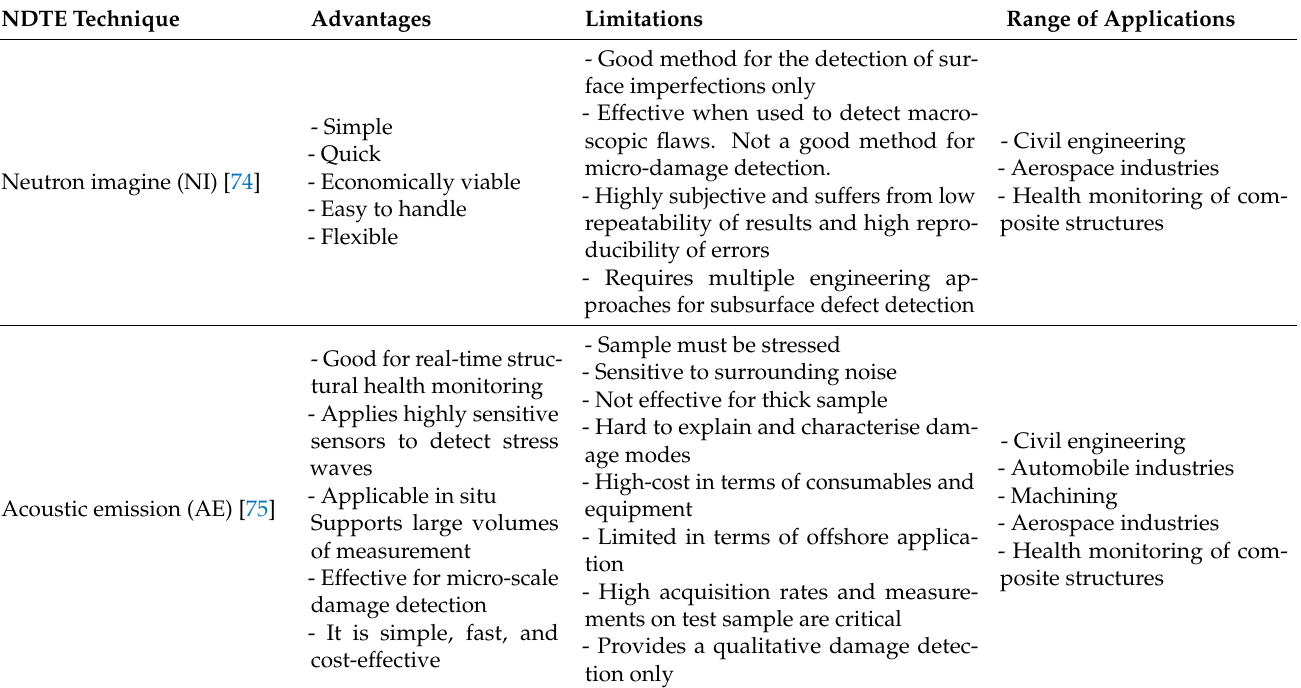
Table 5. The advantages, limitations, and ranges of applications of different NDT